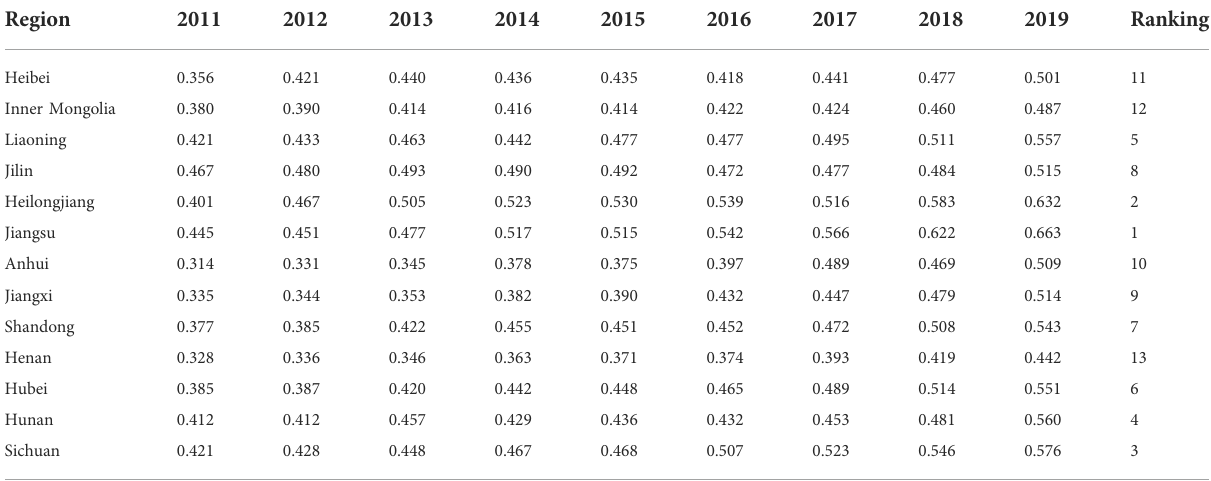
TABLE 6 Calculation results of the green agriculture development index.